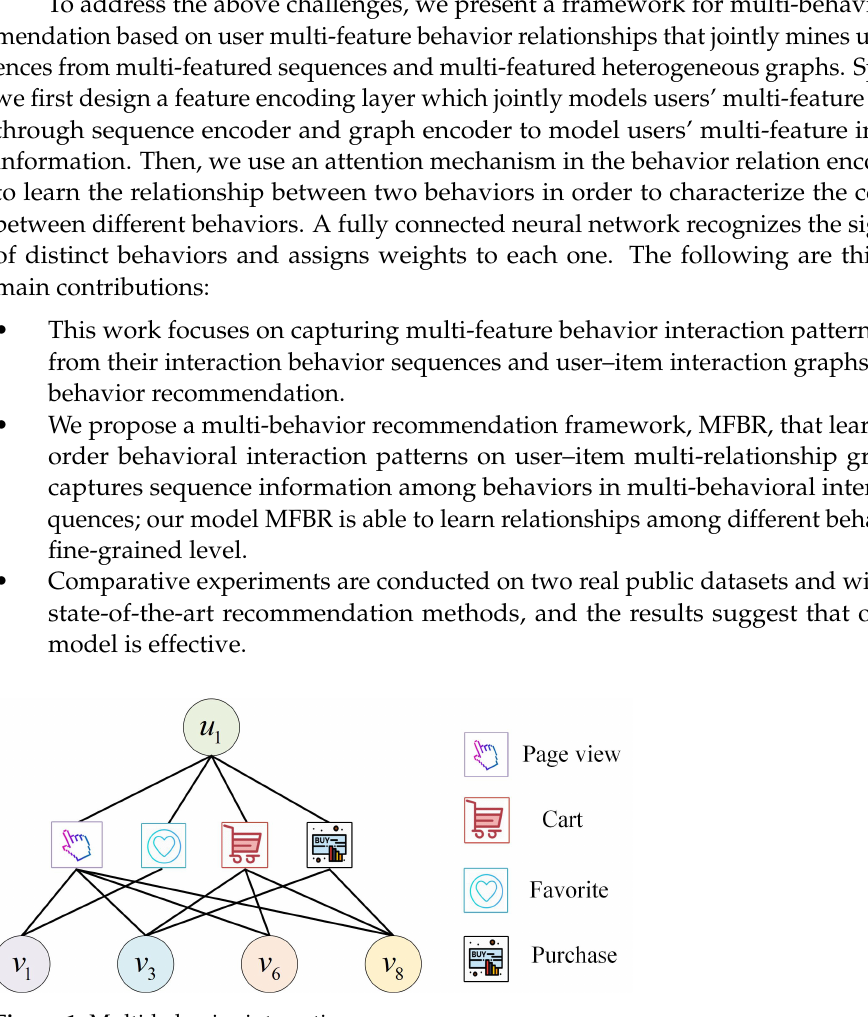
Figure 1. Multi-behavior